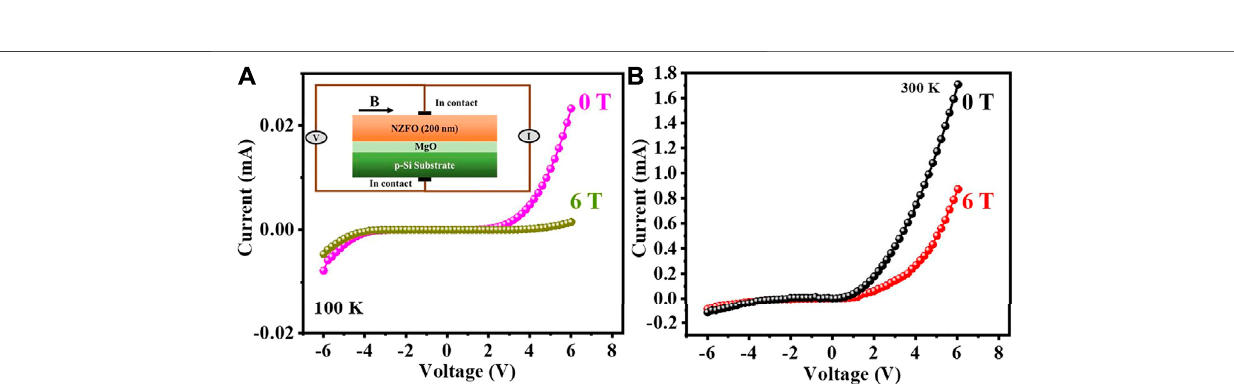
FIGURE 9 | I – V characteristics of the heterostructure at (A) 100 K and (B) 300 K in the absence and presence of applied 6 T magnetic fi eld. The inset of Figure 9A displays the schematic setup for measuring the magneto-transport property of our heterostructure.